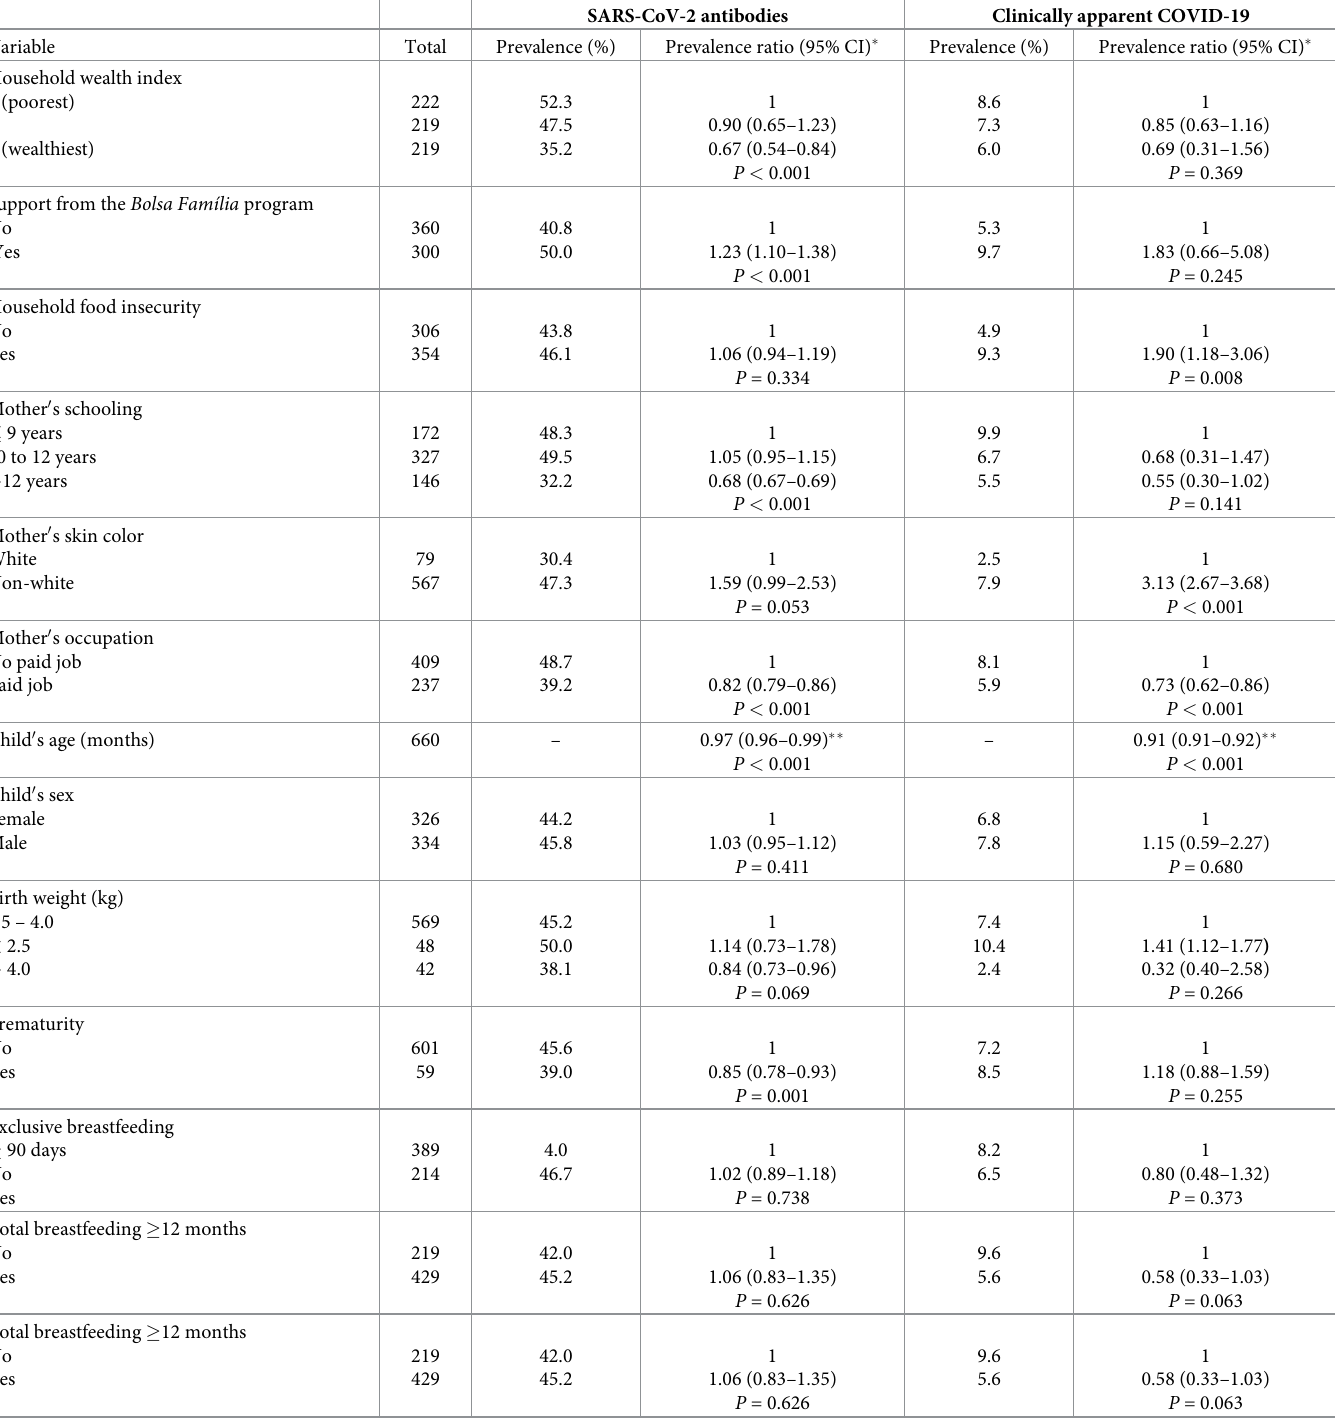
Table 1. Prevalence (%) of SARS-CoV-2 antibodies and prevalence ratio (95% confidence interval) of clinically apparent COVID-19 in 5 years-old Amazonian chil- dren according to sociodemographic, neonatal, nutritional, and morbidity history